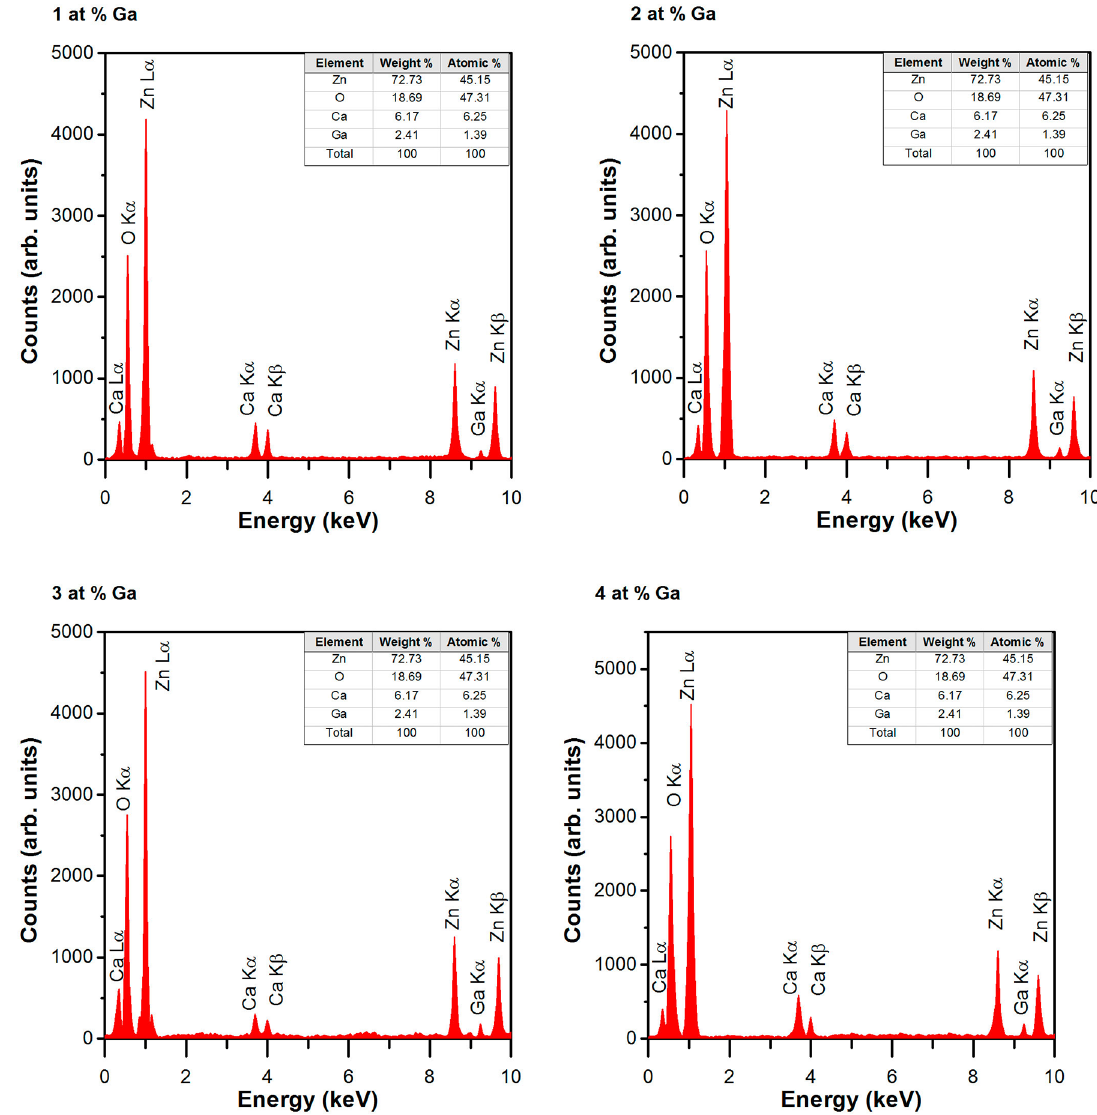
Ca O thin 0.85 0.15